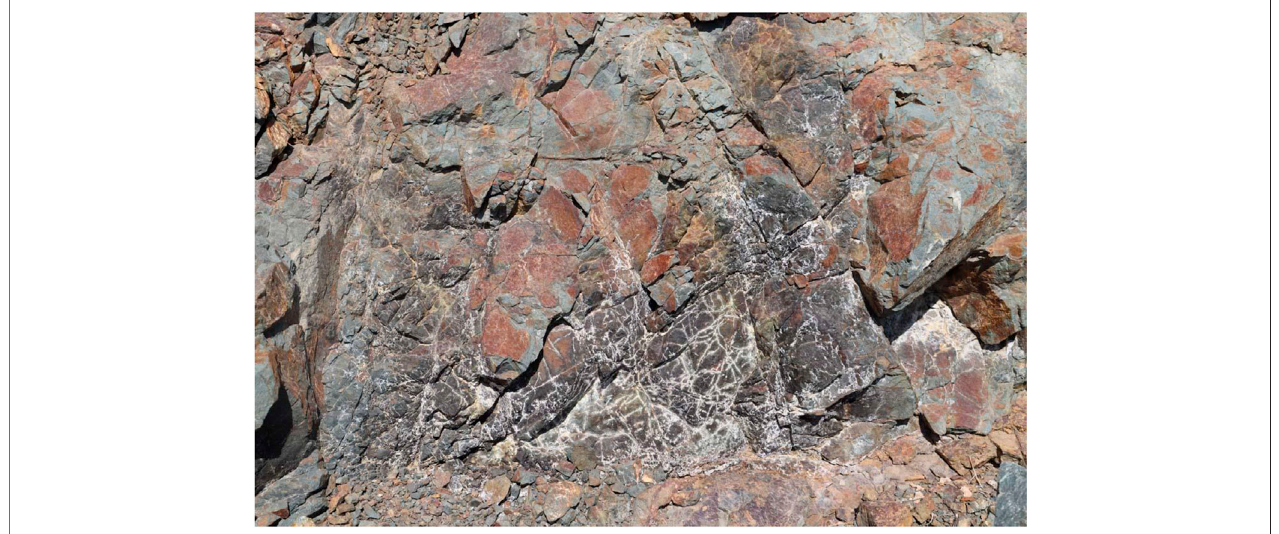
FIGURE 6 | A close-up view of the serpentinized peridotite showing natural fracture sets. There are black manganese oxide stains and brown ferric hydroxide fracture coating related to minor weathering. There are also white carbonate and sulfate encrustations along minor fractures related to groundwater evaporation in the arid climate